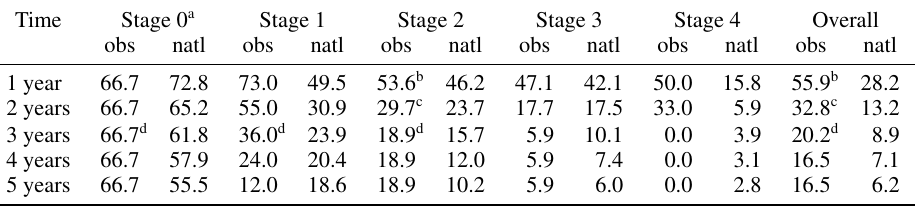
Table 4: Observed (obs) survival rates in our health system compared to national (natl) rates, as reported by the American College of Surgeons Commission on Cancer, during the same time period. Time Stage 0